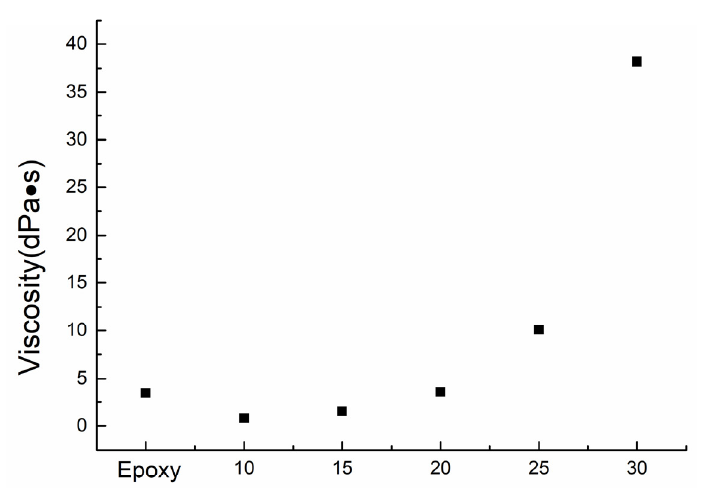
Figure 4. Viscosity of epoxy resin and polyester resin solution at different mass